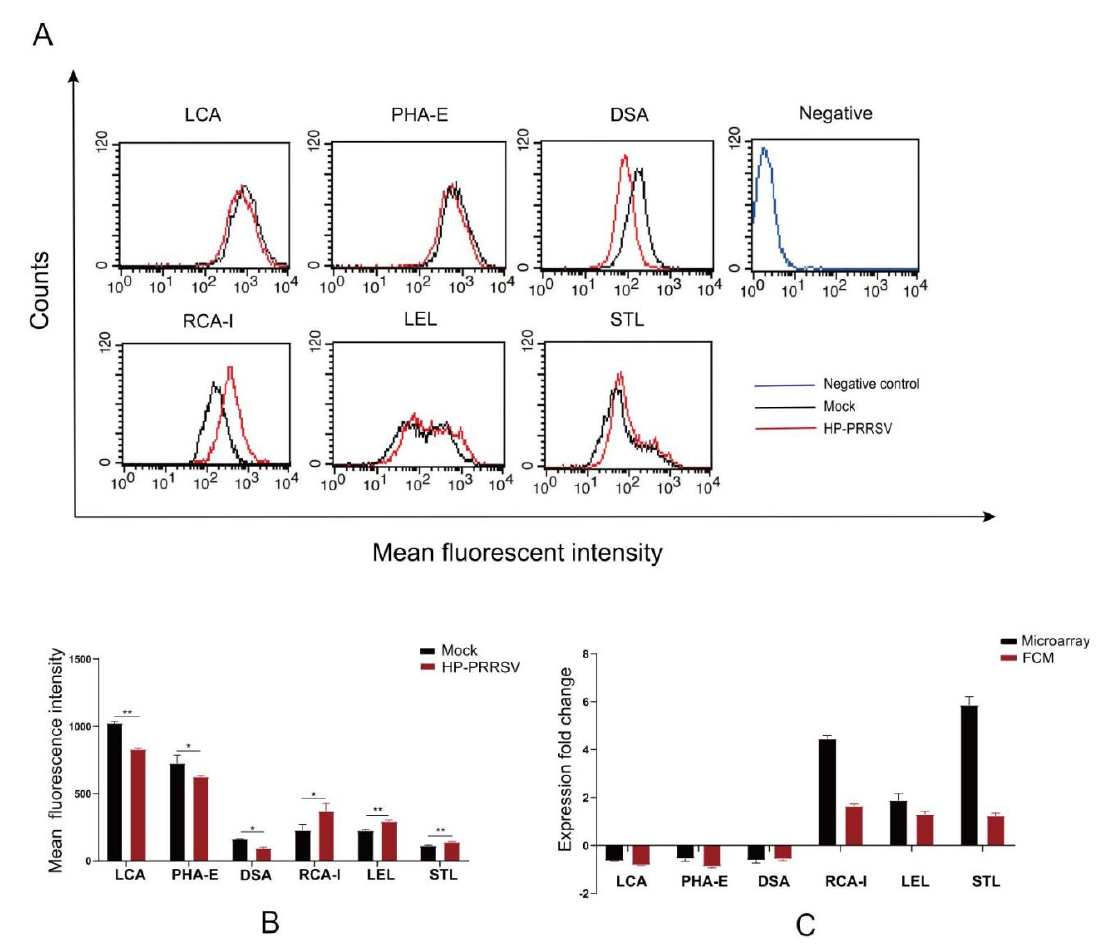
Figure 8. Lectin flow cytometry of HP-PRRSV JXA1-infected PPMVECs. ( A ) Flow cytometry histograms. ( B ) Mean fluorescence intensities. ( C ) Comparison of the fold changes in fluorescence intensities between lectin microarrays and lectin flow cytometry (FCM). Statistical analysis was performed by Student’s t -test. * p < 0.05; ** p < 0.01.